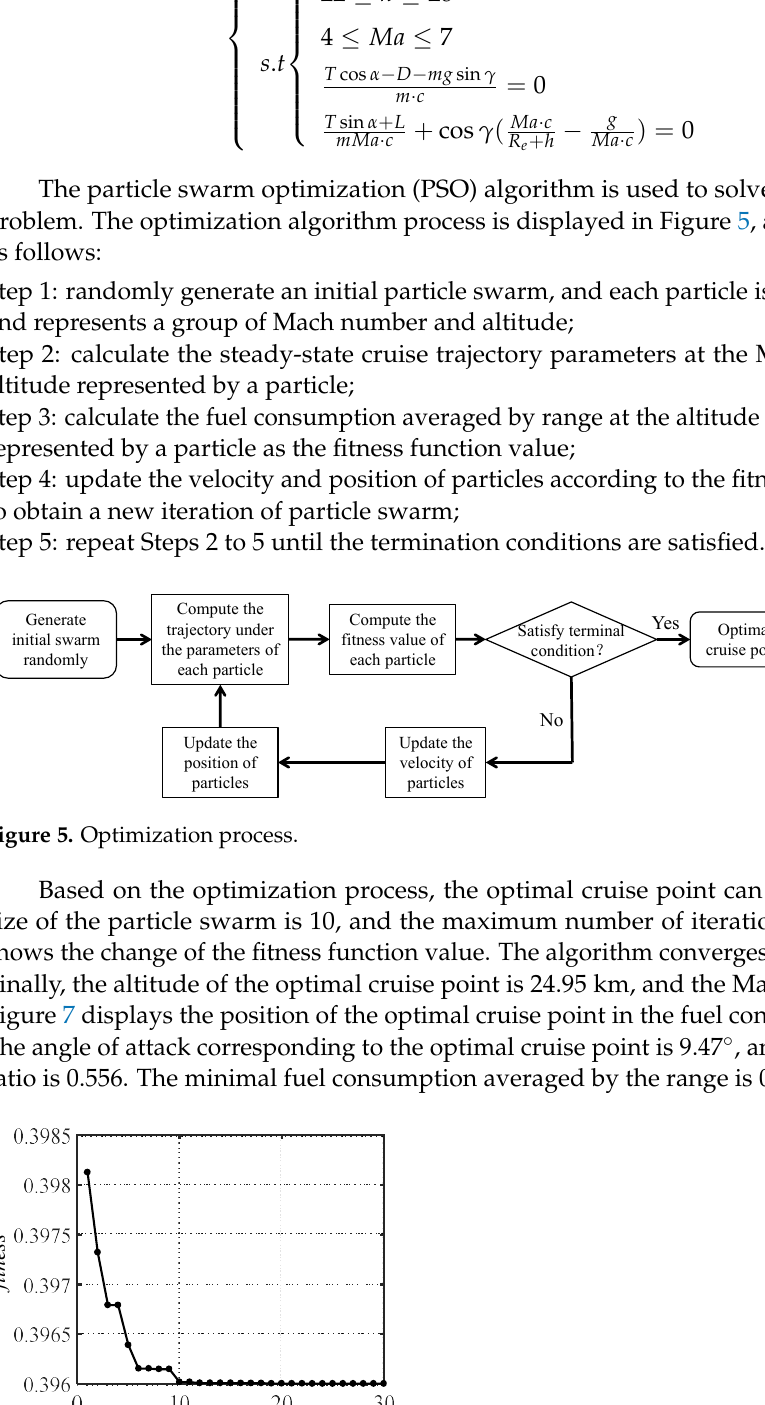
Figure 7. The location of optimal cruise point in the contour of fuel consumption. Therefore, if the aircraft parameters are determined, the position of the optimal cruise point can be obtained quickly and accurately by this PSO algorithm. On this basis, the aircraft parameters can be adjusted and corresponding optimal cruise points can be obtained, then the influence of the aircraft parameters on the optimal cruise point can be explored. 4. Analysis and Modeling of Aircraft Parameters According to previous analysis, for a determined parametric aircraft model, there is a corresponding optimal steady-state cruise point, and the position of the optimal cruise point is determined by the aircraft parameters. How the aircraft parameters affect the position of the optimal cruise point is also a problem worthy of exploration, which has guiding significance for the design of aircraft. 4.1. Analysis of Single Aircraft Parameter The aircraft parameters group studied in this paper includes lift coefficient, drag coefficient, inlet area, specific impulse, aircraft mass, and reference area. These six parameters can be divided into three aspects, as shown in Figure 8: aerodynamic shape (lift coefficient and drag coefficient), propulsion system (inlet area and specific impulse), and structural design (aircraft mass and reference area). Figure 8. Considered parameters in this paper.